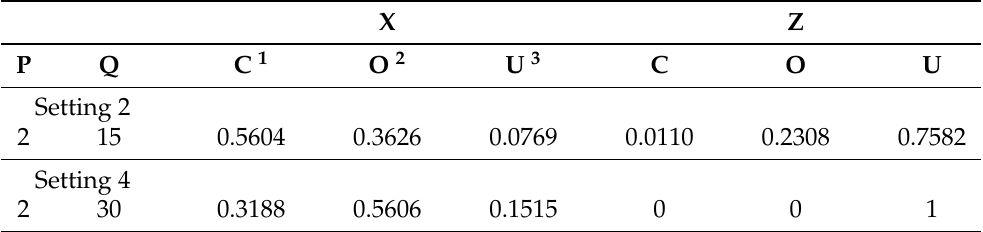
Table 2. Variable selection results for the PLGKM methods, with different numbers of irrelevant z .